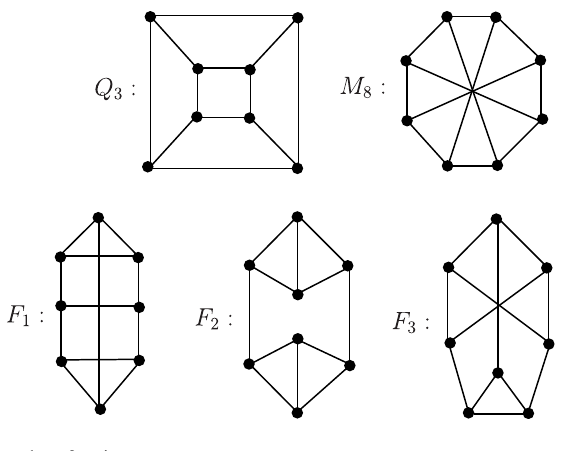
Figure 1: All connected cubic graphs of order